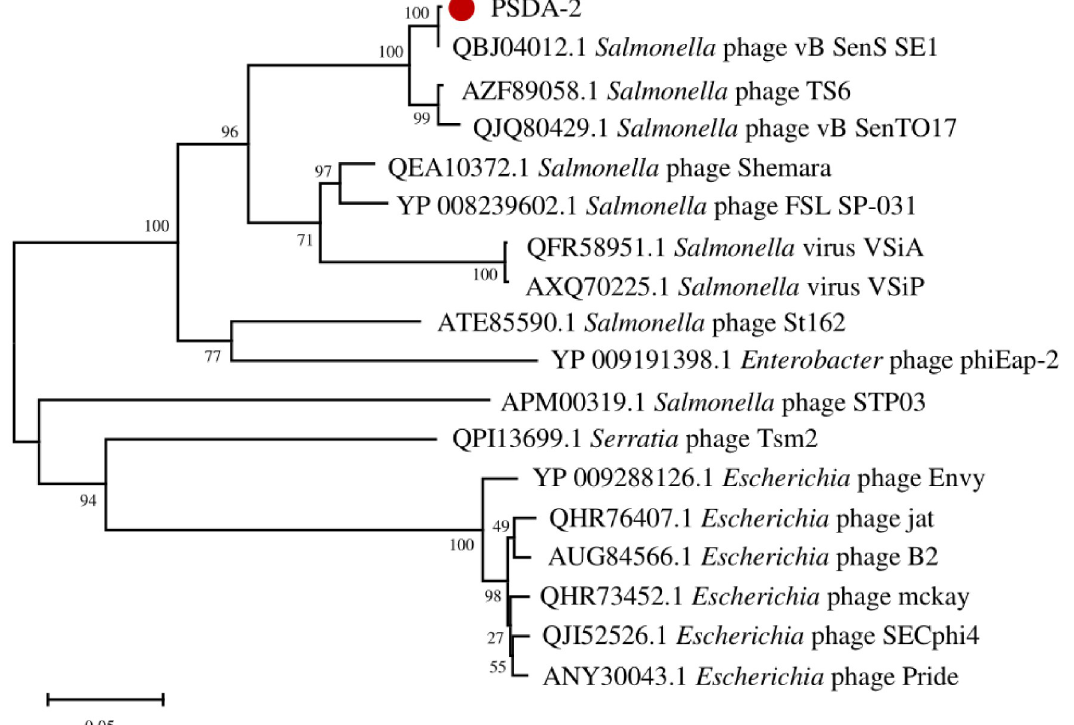
Fig 4. The phylogenetic tree of PSDA-2 based on DNA